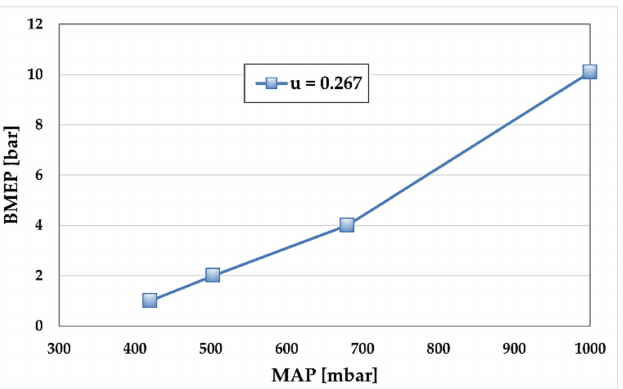
Figure 6. Brake mean effective pressure as a function of manifold absolute pressure ( MAP ) at u =